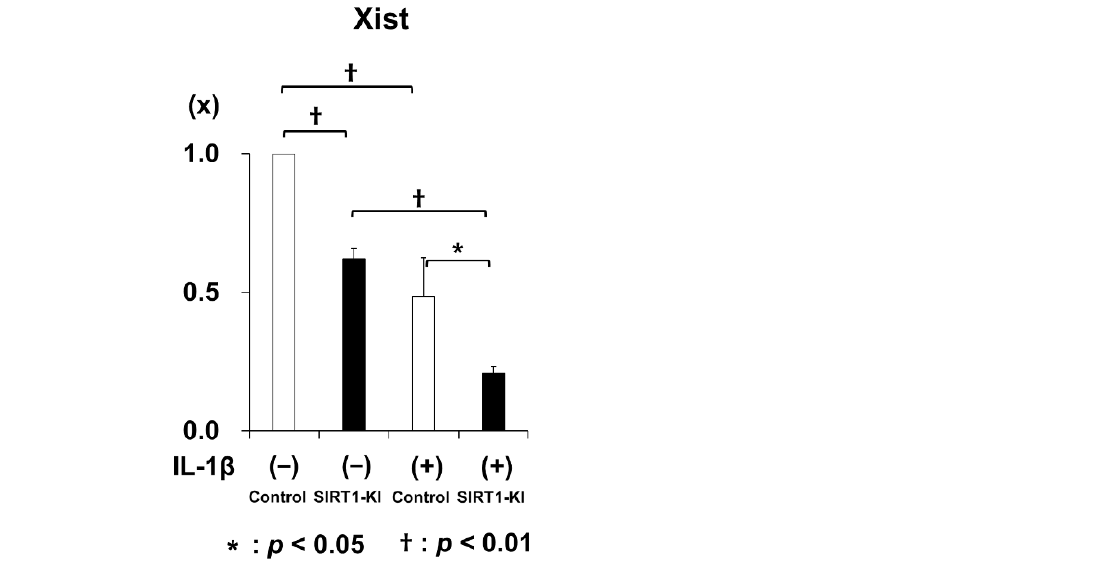
Figure 7. Real-time polymerase chain reaction (PCR) analysis of Xist mRNA expression in primary mouse chondrocytes. Primary mouse epiphyseal chondrocytes were cultured with 10 ng/mL IL-1 β for 24 h ( n = 5 independent experiments; * p < 0.05, † p < 0.01).